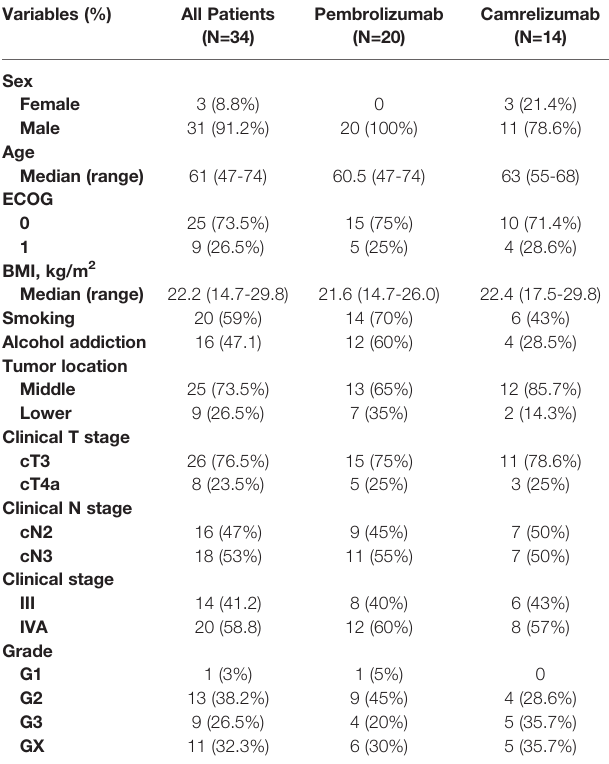
TABLE 1 | Baseline demographics and clinical